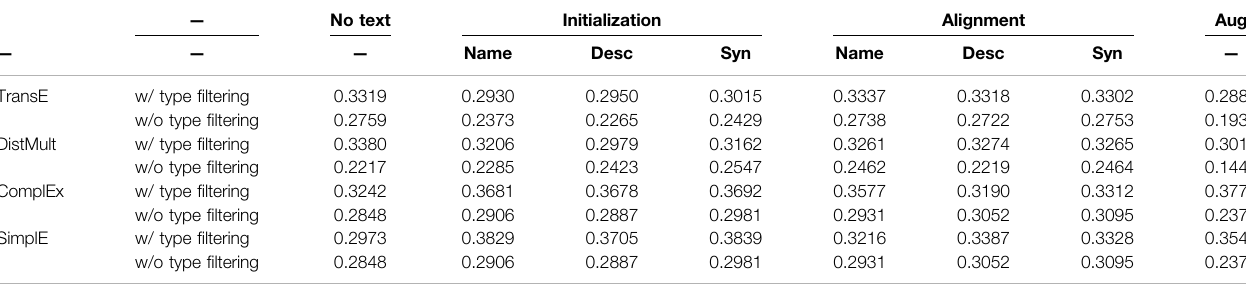
TABLE 7 | Comparison of averaged MRR performance for w/ and w/o entity type fi ltering.